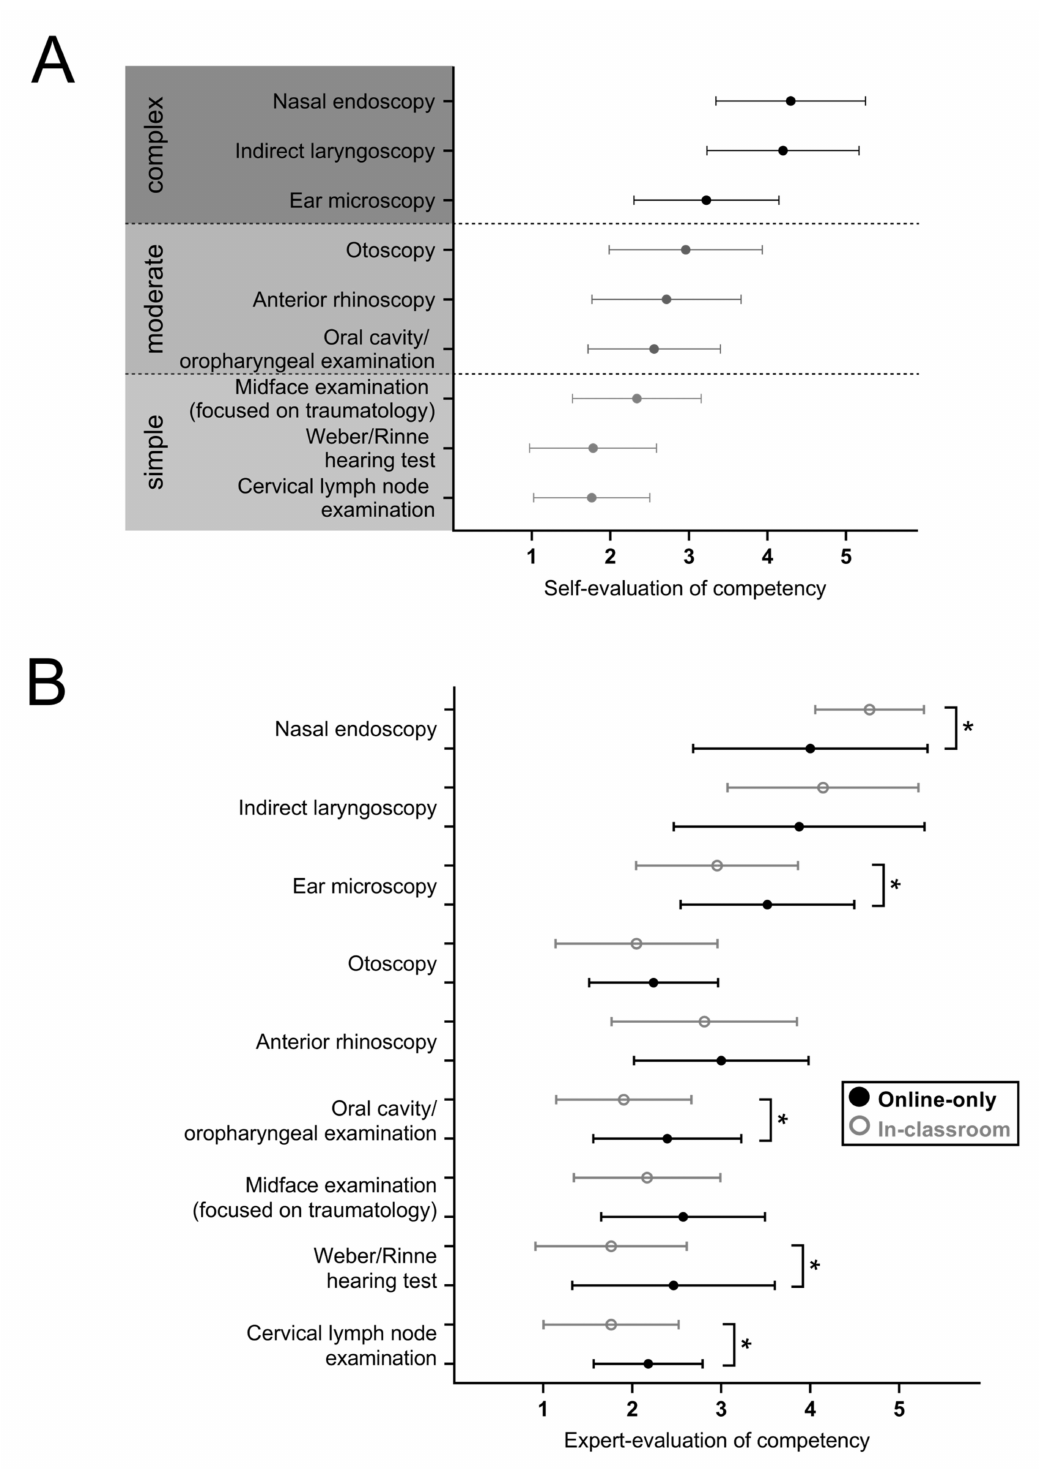
Figure 2. Overall self-evaluation of examination competency and comparison of expert-assessment of examination skills. ( A ) Self-evaluation of skill competency for 9 different ENT examination items is shown. Data are based on all participants irrespective of previous mode of training. Exami- nation items are grouped into simple, moderate and complex tasks. ( B ) Expert-evaluated ratings of competencies in different examination items is shown, comparing participants who received in-classroom-teaching vs. online-only teaching. Self-/expert-evaluation is measured on a 5-point interval scale (Likert scale; 1 = high proficiency to 5 = low proficiency); * p <